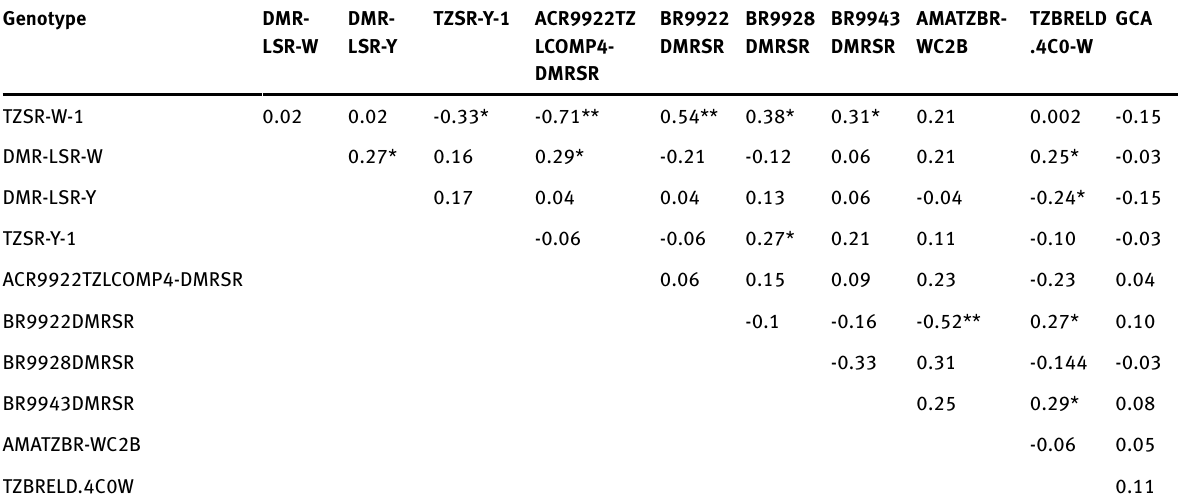
Table 6: General and Specific combining ability (GCA) and (SCA) for grain yield under high-N environment at Mokwa and Zaria, 2012